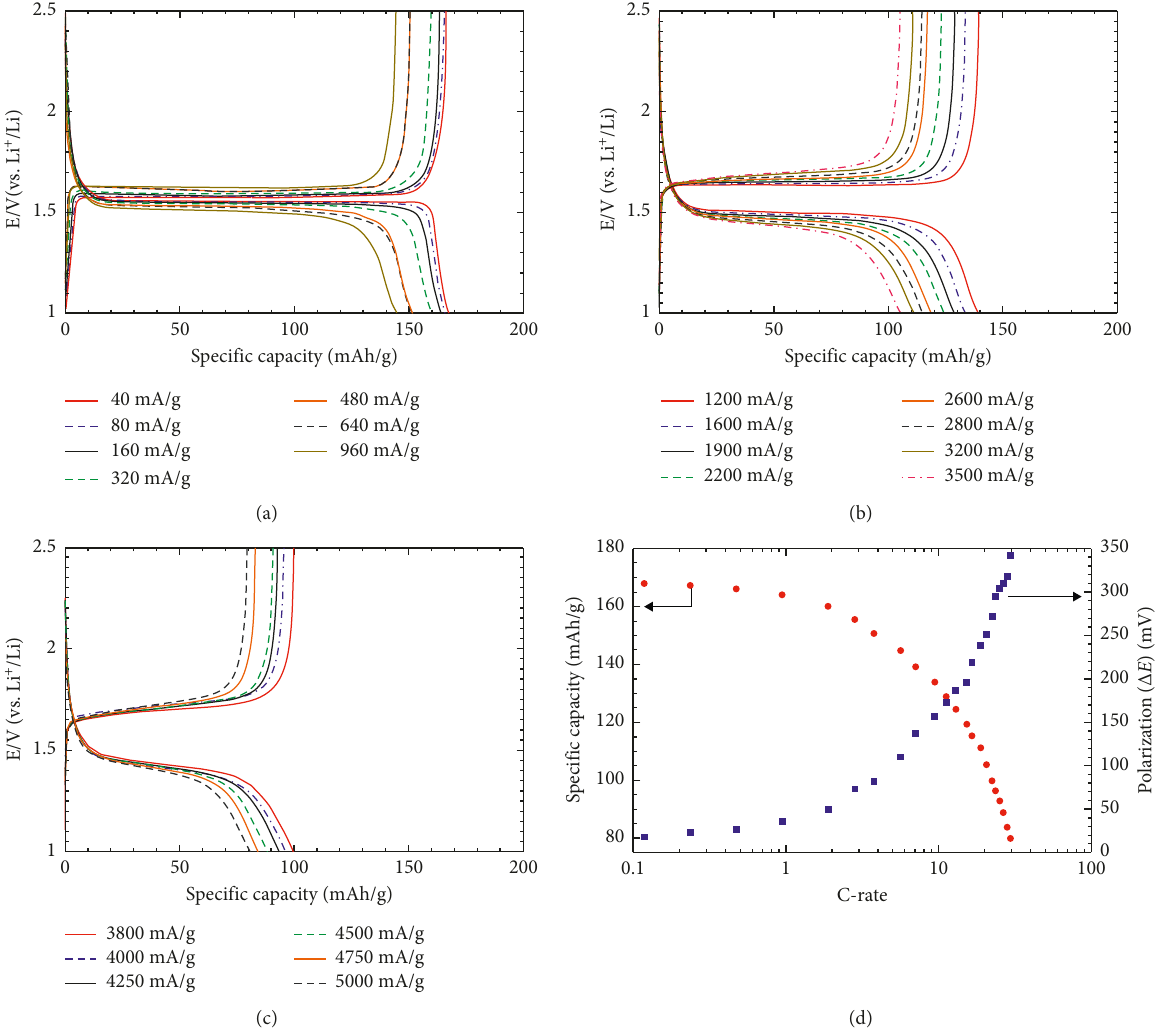
Figure 7: (a–c) Charge-discharge profile of Li 4 Ti 5 O 12 at various current densities from 40mA/g to 5000mA/g and (d) electrode polarization and specific capacity as the function of C-rate.